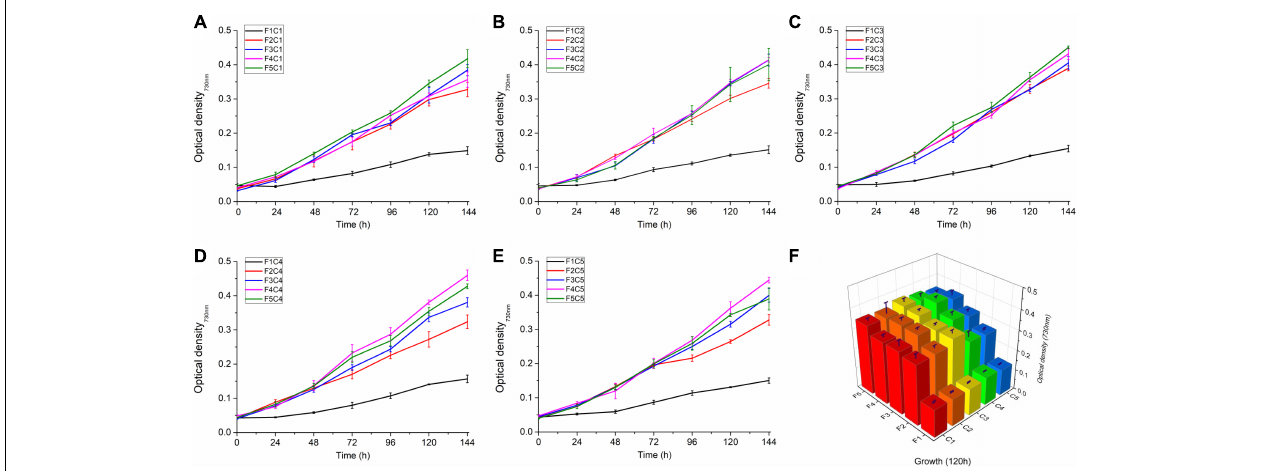
FIGURE 1 | Growth of Synechocystis sp. PCC 6803 under different Cu and Fe concentrations. (A–E) The growth curve of Synechocystis sp. PCC 6803 in the presence of different combinations of copper and iron concentrations; (F) Growth of Synechocystis sp. PCC 6803 at 120 h. C1 ∼ C5 indicate Cu concentrations of 0, 112.5, 225, 337.5, and 450 nM, respectively; F1 ∼ F5 indicate Fe concentrations of 0, 6.25, 12.5, 18.75, and 25 µ M,